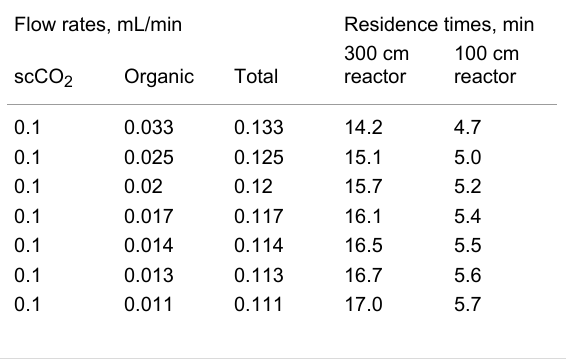
Table 1: Correlation of reaction flow rates to reactor residence times. Flow rates, mL/min Residence times, min scCO